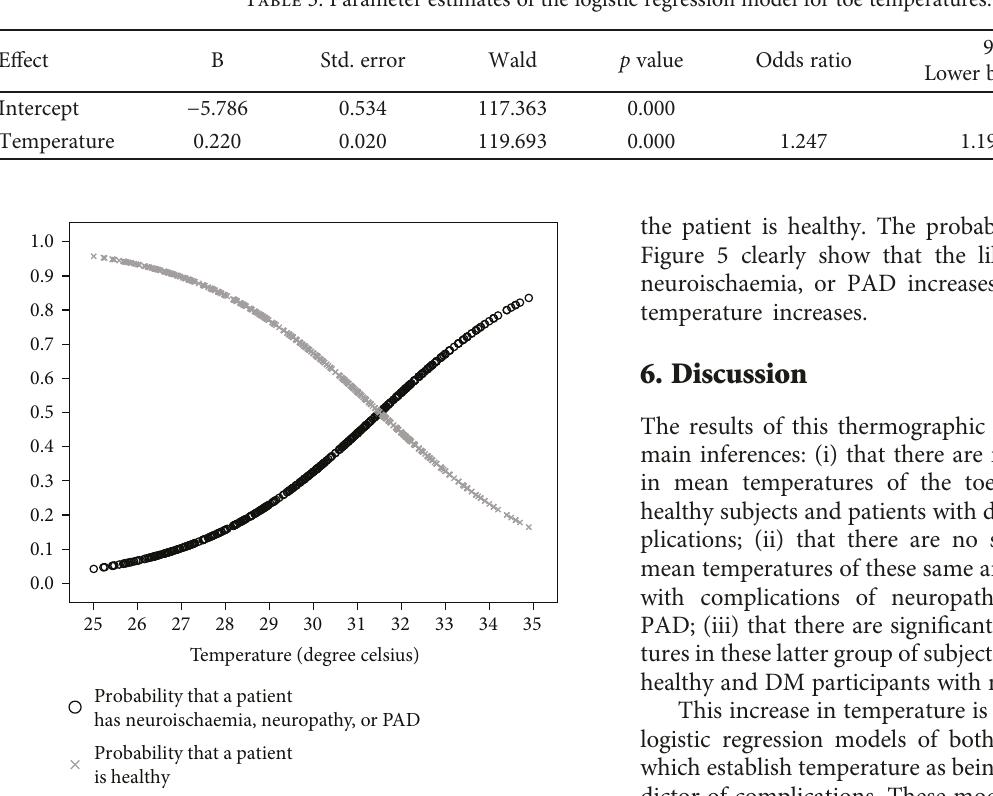
Figure 4: Logistical regression curves of toe temperatures. Table 4: Likelihood ratio tests (model